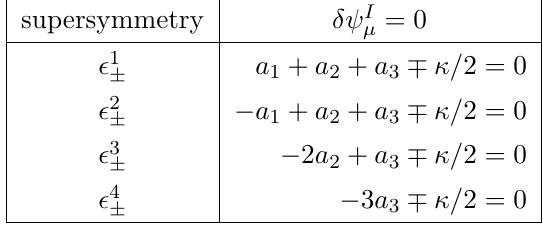
Table 10 . Supersymmetry equations for N = 4 theories.